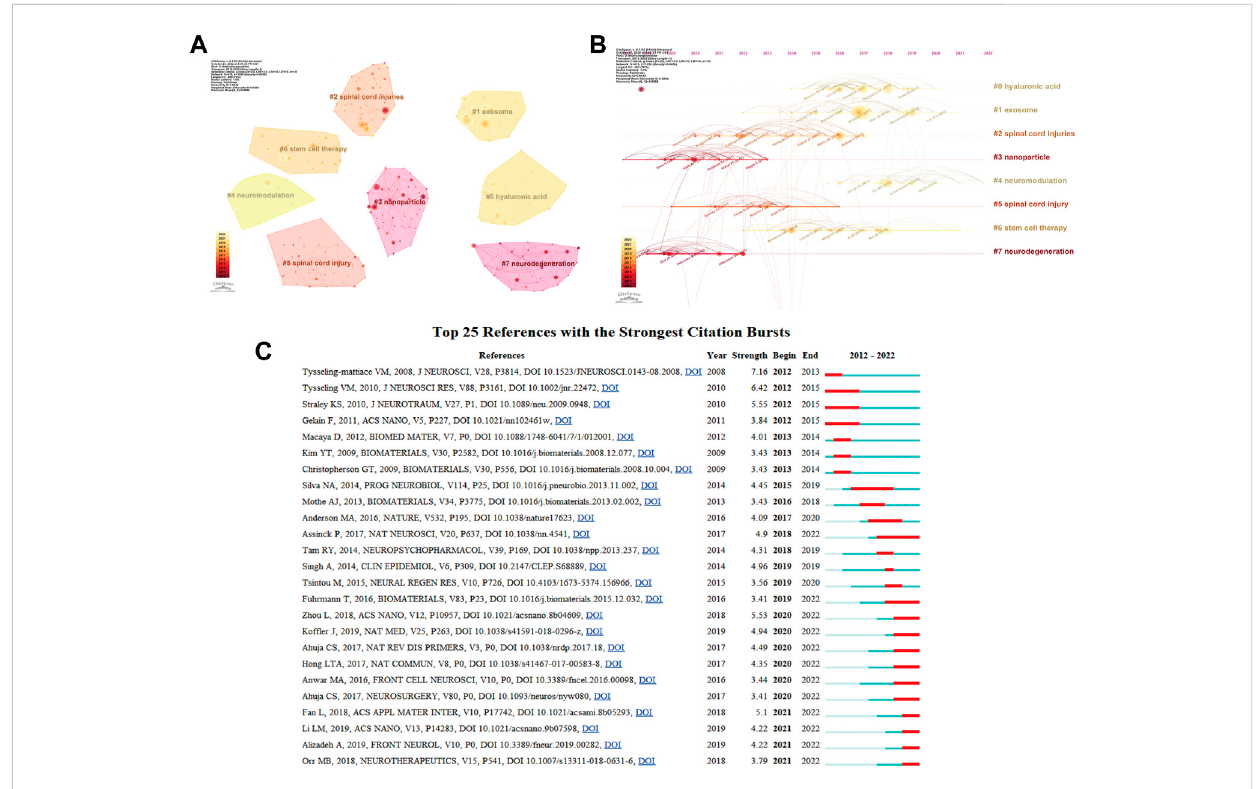
Figure 5Bdepicts the development of this topic wordthroughouttime.